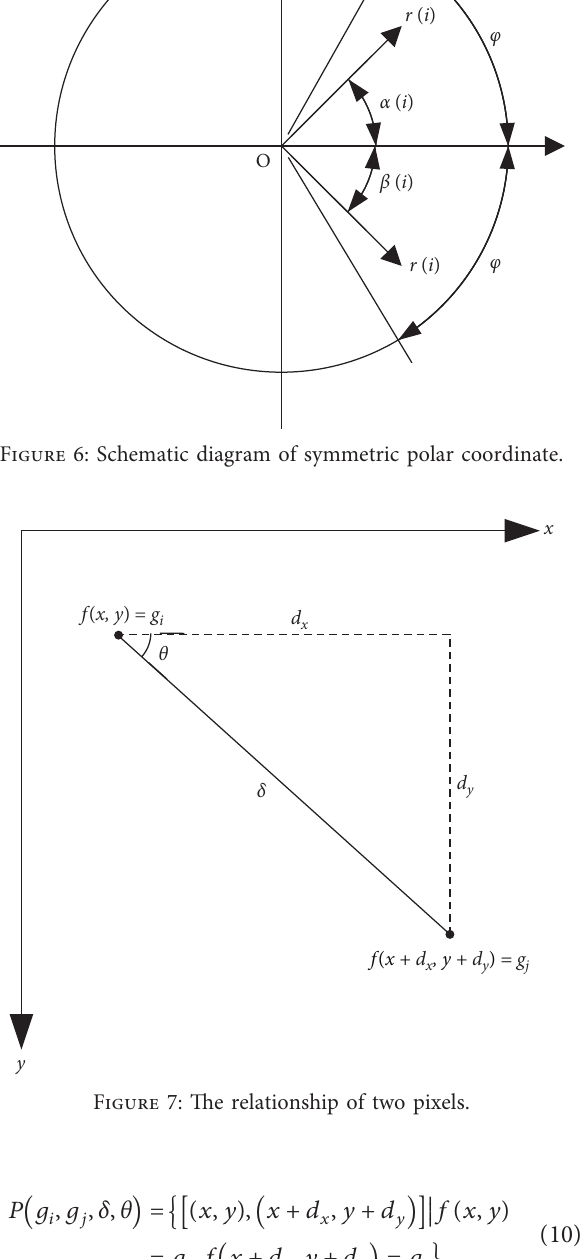
gray level of the image; x , y are the horizontal and vertical values of coordinate of a certain pixel in the image, x � 0, 1, 2, . . . , L , y � 0, 1, 2, . . . , L , L , L are the number of rows x − 1 y − 1 x y and columns of image pixels, respectively; δ is the distance between two pixels; and θ is the angle between the con- necting line of two pixels and the horizontal line [25].